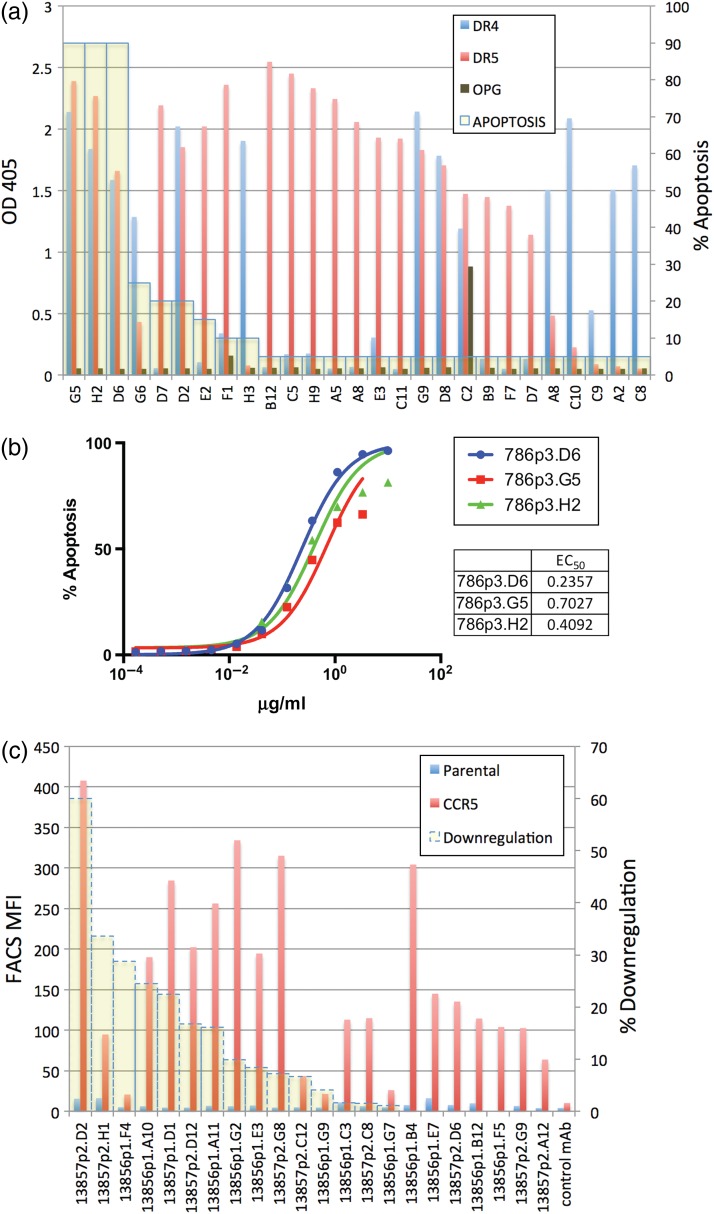
Specificity and activity of DR4/DR5 antibodies and CCR5 antibodies. (a) Left axis is ELISA OD values on DR4, DR5 and OPG coated plates; right axis is percentage of apoptotic Jurkat T cells after overnight incubation in supernatant of each clone. (b) Apoptosis assay dose response of three selected DR4/DR5 cross-reactive clonal supernatants on Jurkat T cells. (c) Specificity and activity of CCR5 antibody clones. The left axis is FACS staining SupT1 CCR5-M10 and parental cells; the right axis is percentage of downregulation of surface CCR5 expression on SupT1 CCR5-M10 cells after 48 h incubation.